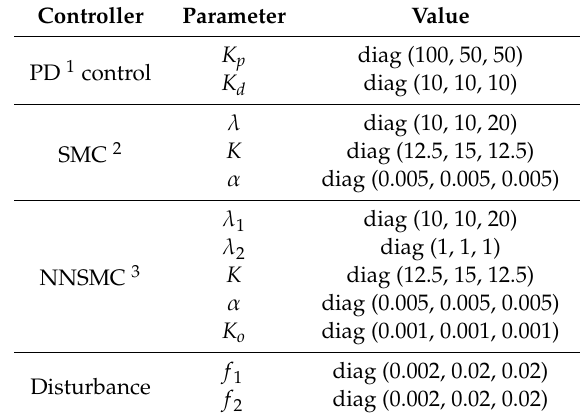
Figure 5. The external payload mass profile. Table 2. Initial parameters of the three